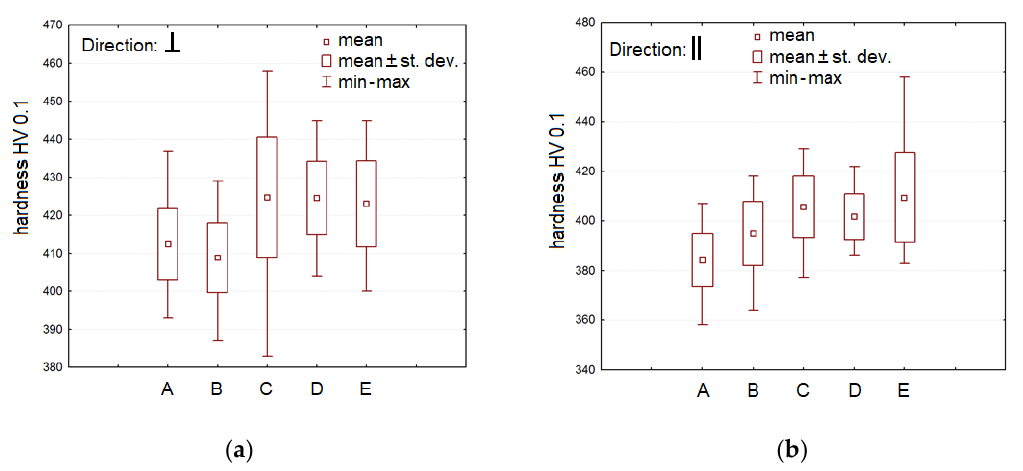
Figure 6. The hardness of the material in particular positions in the ( a ) ⊥ and ( b ) ‖ directions. The results of the ANOVAs are shown in Table 3. The results of the ANOVAs are shown in Table 3. Table 3. Results of analysis of variance (ANOVA) for the assessed Table 3. Results of analysis of variance (ANOVA) for the assessed directions.